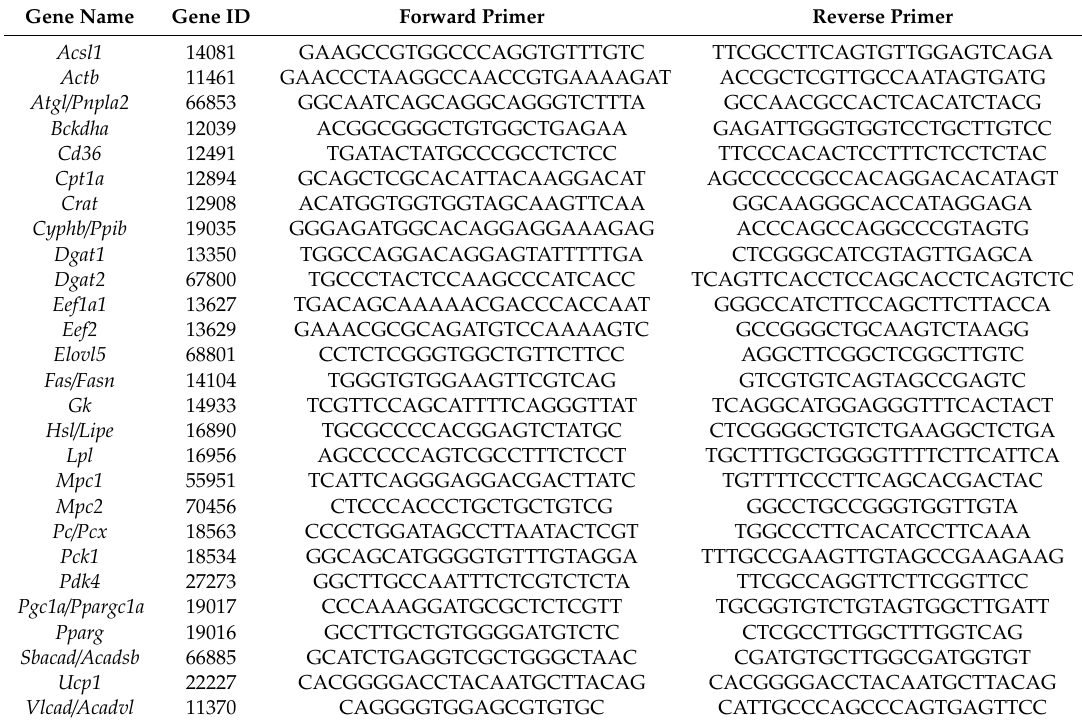
Table 1. Sequences of